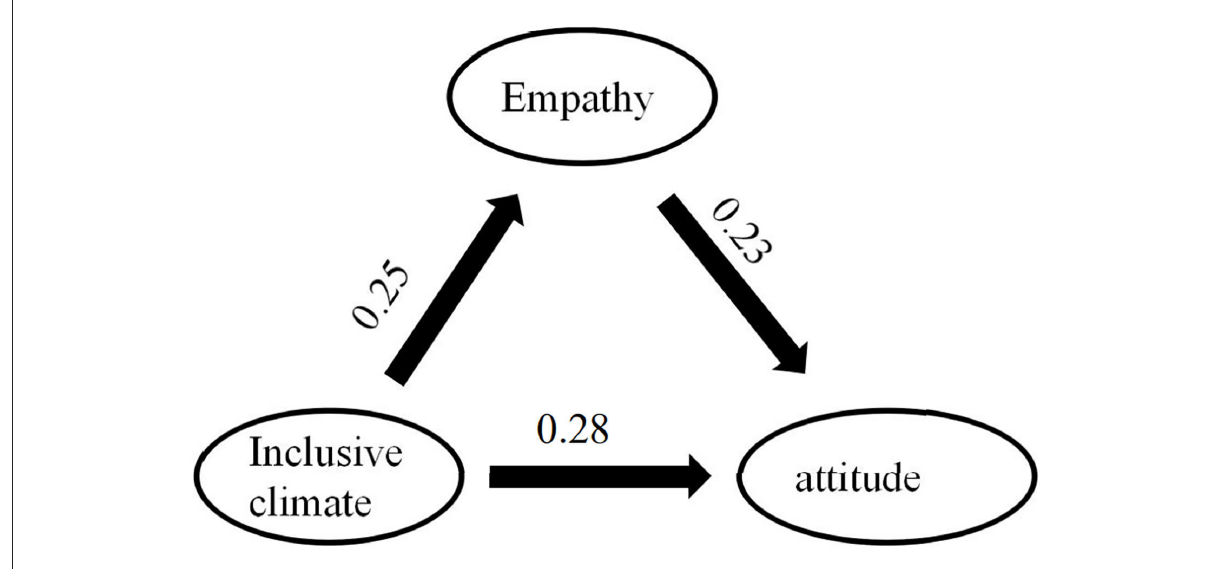
FIGURE1 Mediation effect of empathy between inclusive climate and attitude.